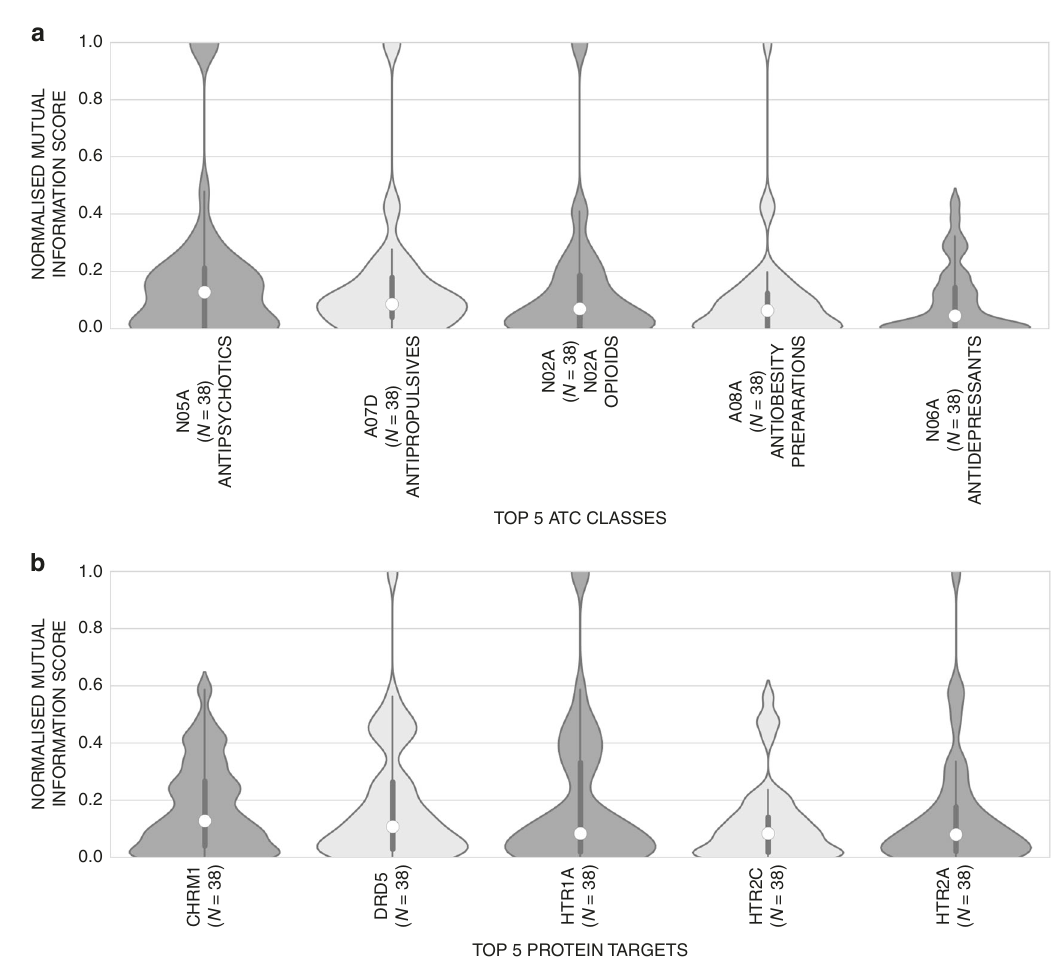
Fig. 8 Top fi ve most informative ATC classes based on neurotransmitter response patterns. a The top 5 informative codes ranked by median score are shown using kernel density estimation (with the lower- and upper-quartile ranges shown using the thicker central lines), which highlights which ATC classes are most correlated with neurochemical response. The distributions comprise a bell shape around scores of ~0.1. Classes are ranked left to right in descending order of median mutual information scores. b Top fi ve most informative protein targets based on neurochemical response fi ngerprints. The distribution of the top 5 targets are shown using kernel density estimation (with lower- and upper-quartile ranges shown). and appear to be more informative than compared to the top 5 most informative ATC classes, since they comprise wider peaks around scores of ~0.5. Hence the most informative predicted protein targets appear to more predictive of neurochemical response then compared to the top ATC codes. Four of the top fi ve targets are serotonin (HTR1A, HTR2C and HTR2A) or dopamine (DRD5) receptor related. Targets are ranked left to right in descending order of median